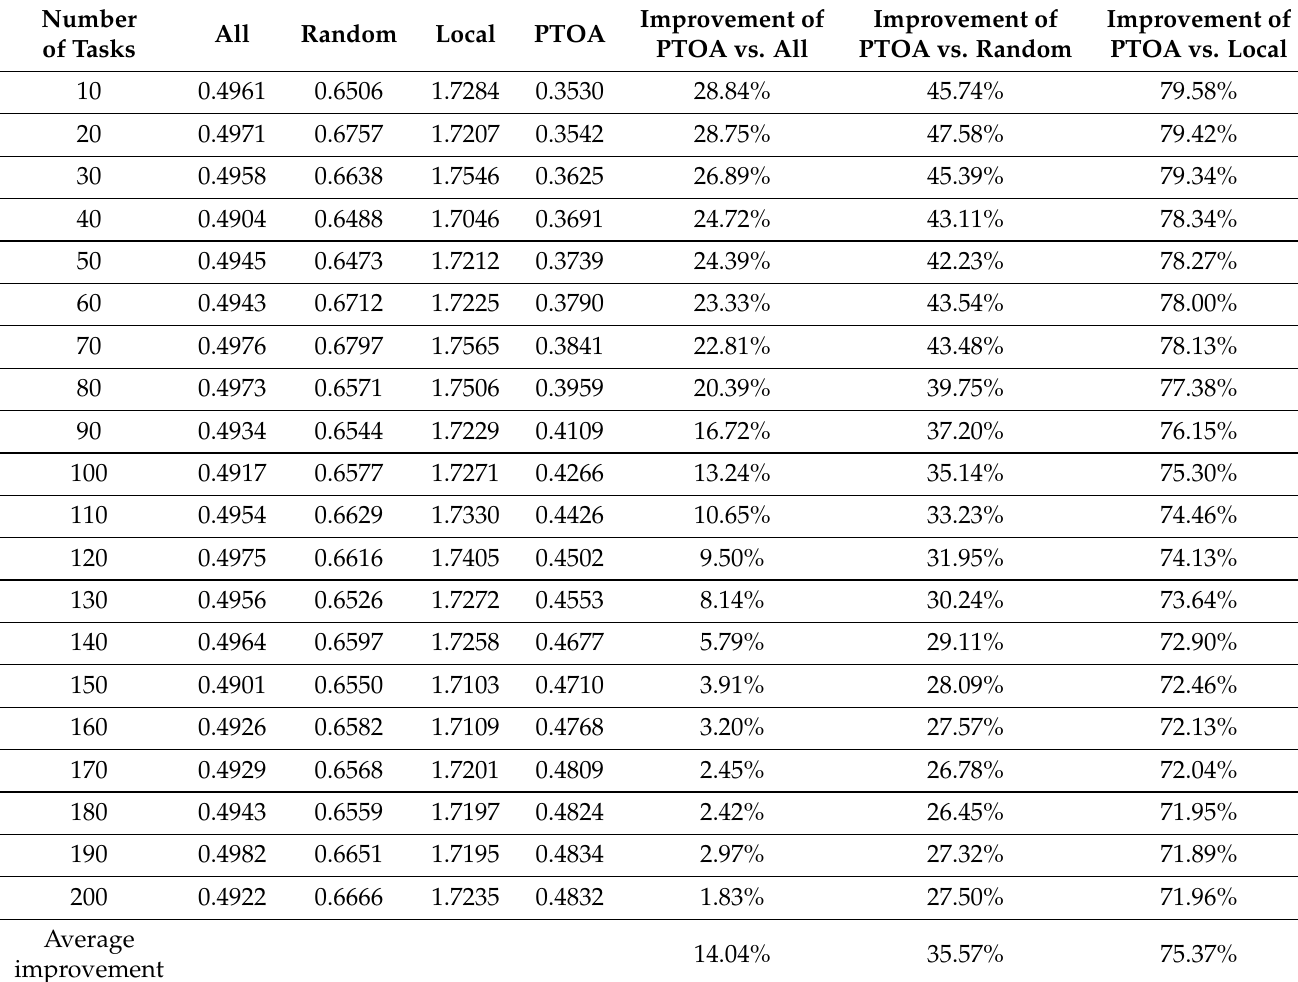
Table 3. Comparison of the average completion time of PTOA with the methods All, Random, and Local with different numbers of